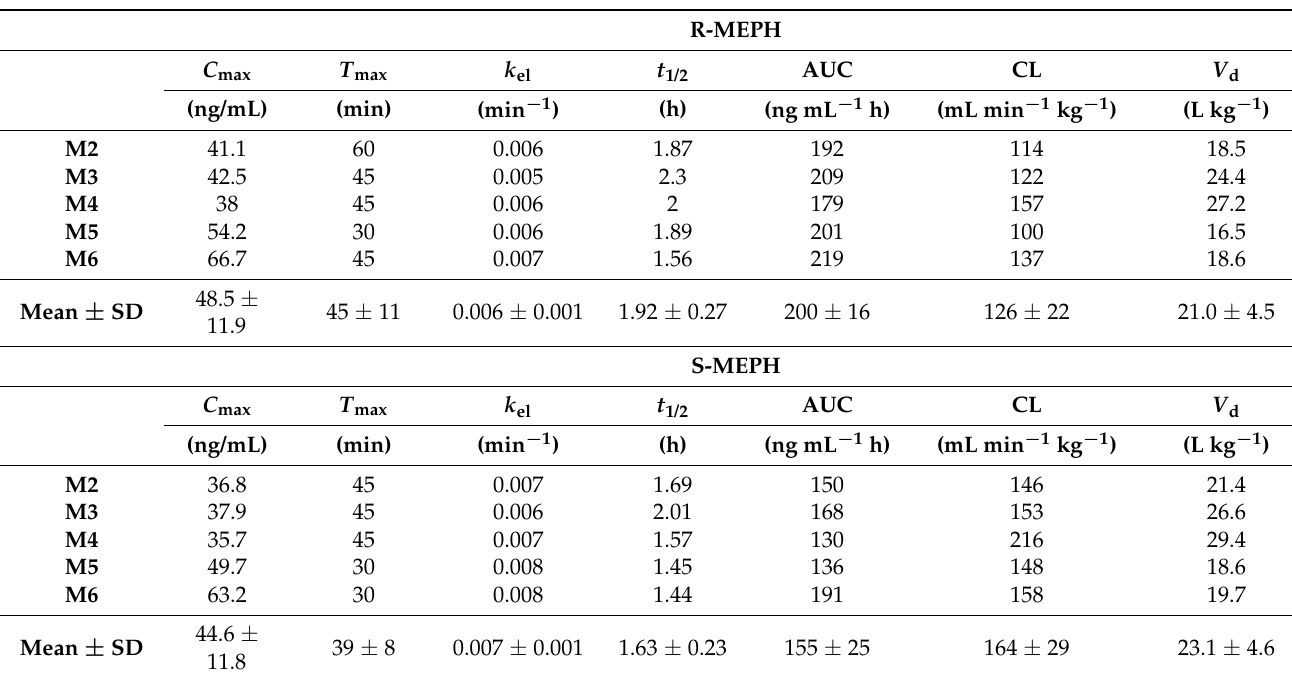
Table 1. Pharmacokinetic data from the analysis of R-(+)-mephedrone (R-MEPH) and S-( − )-mephedrone (S-MEPH) in whole blood samples from five male participants